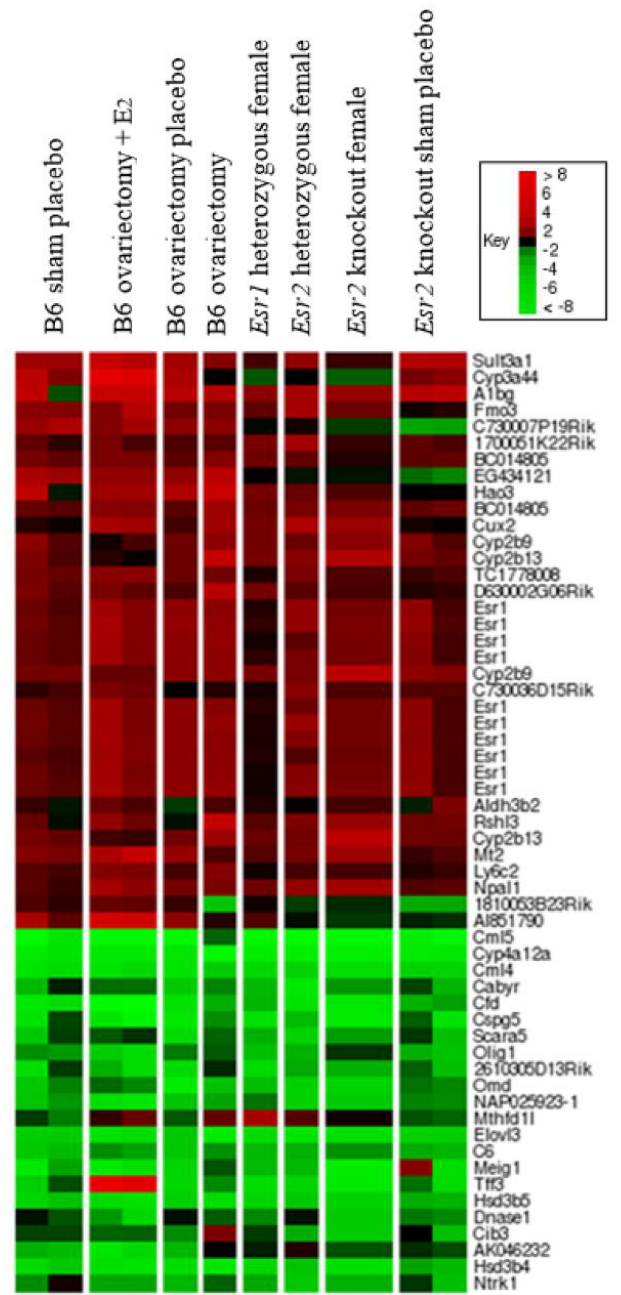
Figure 4. Estrogen Receptor- α -dependent gene expression is not altered in Estrogen Receptor heterozygotes, Estrogen Receptor- β knockout mice or in B6 females following alteration of ovarian hormones. Estrogen Receptor- α ( Esr1 ) regulated transcripts in female mice showing at least 5-fold relative expression difference compared to wild-type (WT) female littermates are shown. Each lane represents microarray results from a pool of livers from individual mice sacrificed at 9–10 weeks of age. Duplicate arrays are shown for Lane 1: C57BL/6J (B6) sham operation placebo group ( n = 7) and Lane 2: B6 ovariectomized animals with 17 β -Estradiol add-back ( n = 6) (Lane 2). A single array is shown for Lane 3: a pool of B6 females that underwent ovariectomy and implantation of a placebo pellet ( n = 6), Lane 4: B6 animals with ovariectomy but no placebo implant ( n = 5), Lane 5: Esr 1 heterozygous females ( n = 6), and Lane 6: Esr 2 heterozygous females ( n = 6). Duplicate arrays are shown for Lane 7: Esr 2KO females ( n = 8), and Lane 8: sham-operated Esr 2KO females with placebo implants ( n = 6).